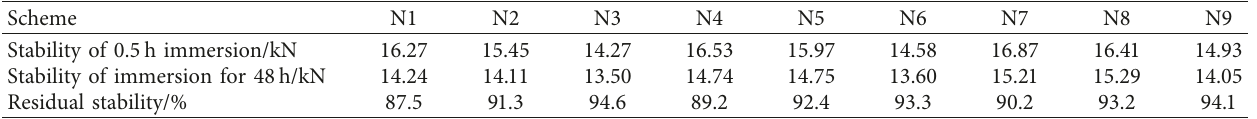
Table 11: Results of immersion Marshall test.